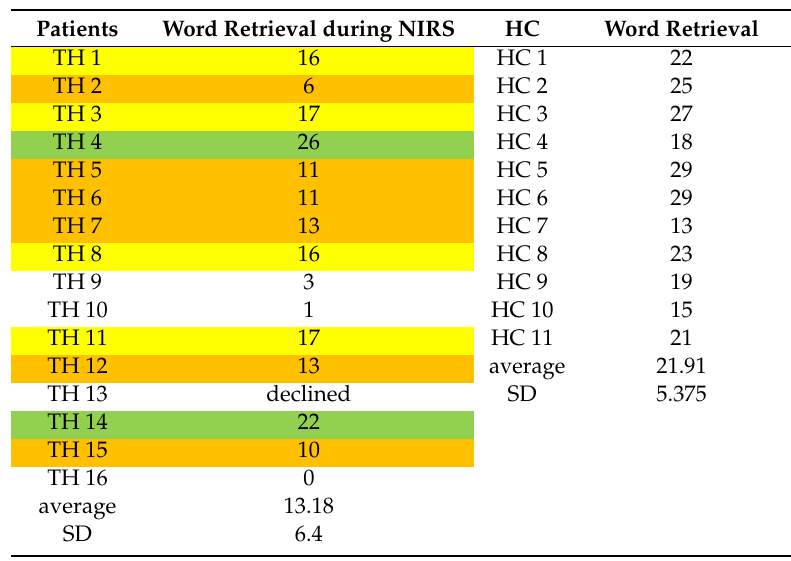
Table 4. Word retrieval performances during NIRS sessions for patients and age-matched controls. Patients were classified in terms of their word retrieval performance. Poor performance group was highlighted in orange, moderate performance in yellow, and good performance in